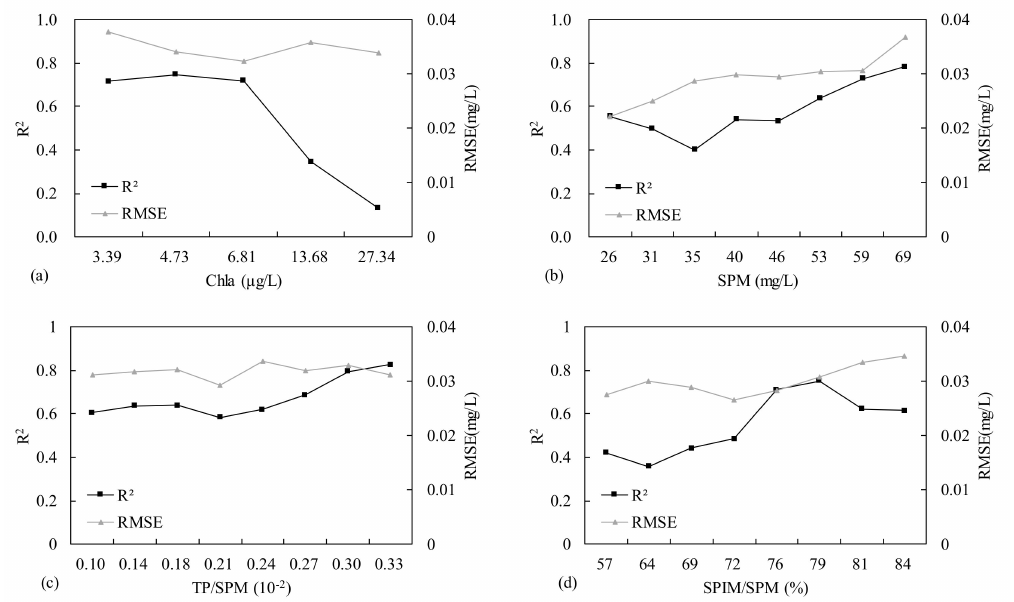
Figure 6. Algorithm accuracy change with di ff erent substance changes. ( a ) Chlorophyll-a (Chla); ( b ) SPM; ( c ) TP / SPM; ( d ) SPIM /